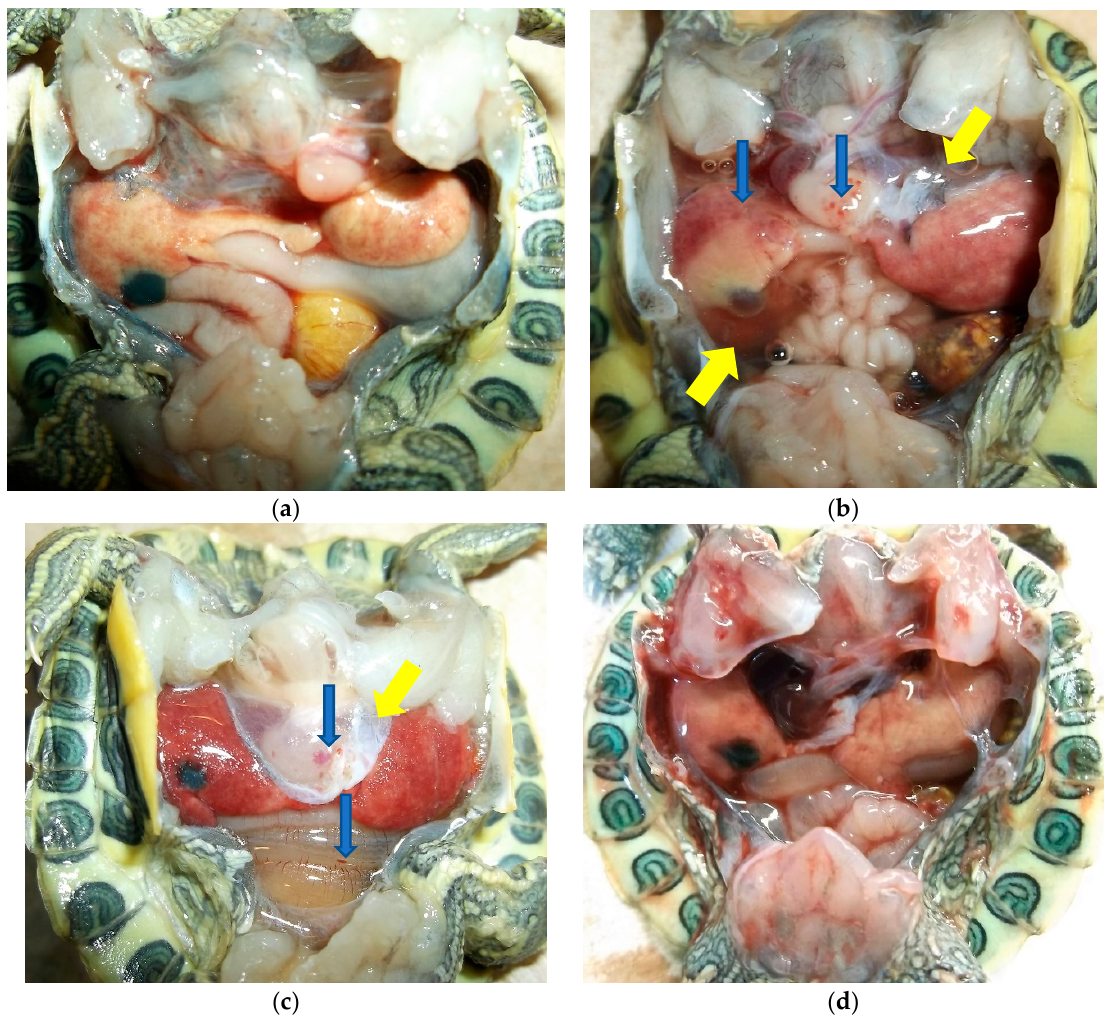
Figure 1. Representative images from necropsies of hatching turtles ( Trachemys scripta elegans ), showing liver discoloration due to ranavirus infection and herbicide exposure versus control conditions: ( a ) Turtle 41 (no herbicide, no ranavirus) control; ( b ) Turtle 78 (Rodeo, ranavirus-exposed) with petechial hemorrhaging on serosal surfaces (blue arrows) and edema fluid expanding soft tissue (yellow arrows); ( c ) Turtle 18 (no herbicide, ranavirus-exposed) with petechial hemorrhaging on serosal surfaces (blue arrows) and edema fluid expanding soft tissue (yellow arrows); ( d ) Turtle 13 (Rodeo, no ranavirus) control.